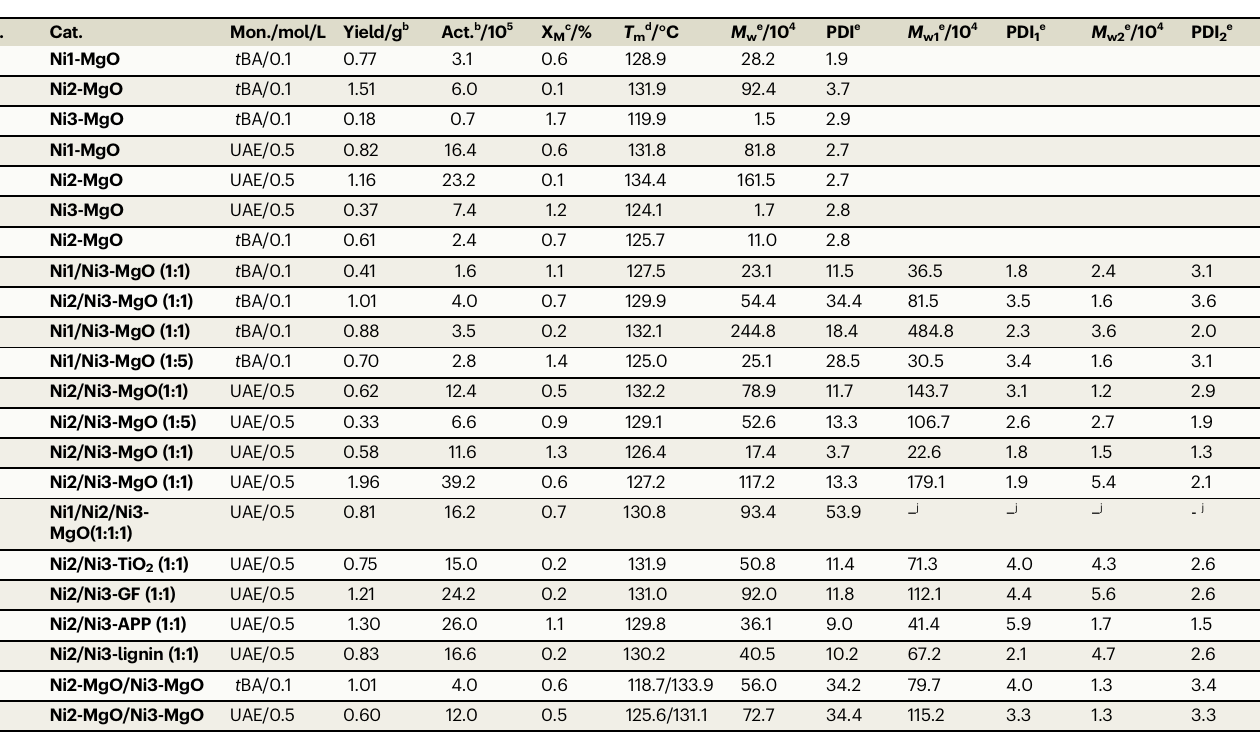
Table 1 | Ethylene copolymerization with Ni catalysts a